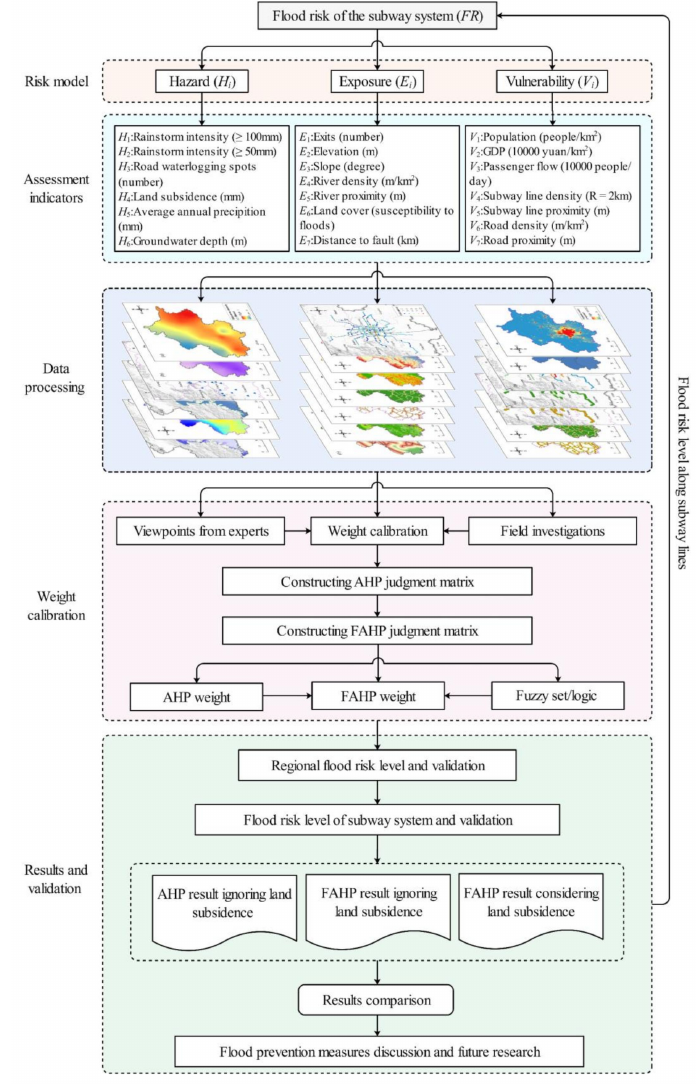
Figure 3. Flowchart of the flood risk assessment for the Beijing subway system. (AHP is analytic hierarchy process; FAHP is fuzzy analytic hierarchy